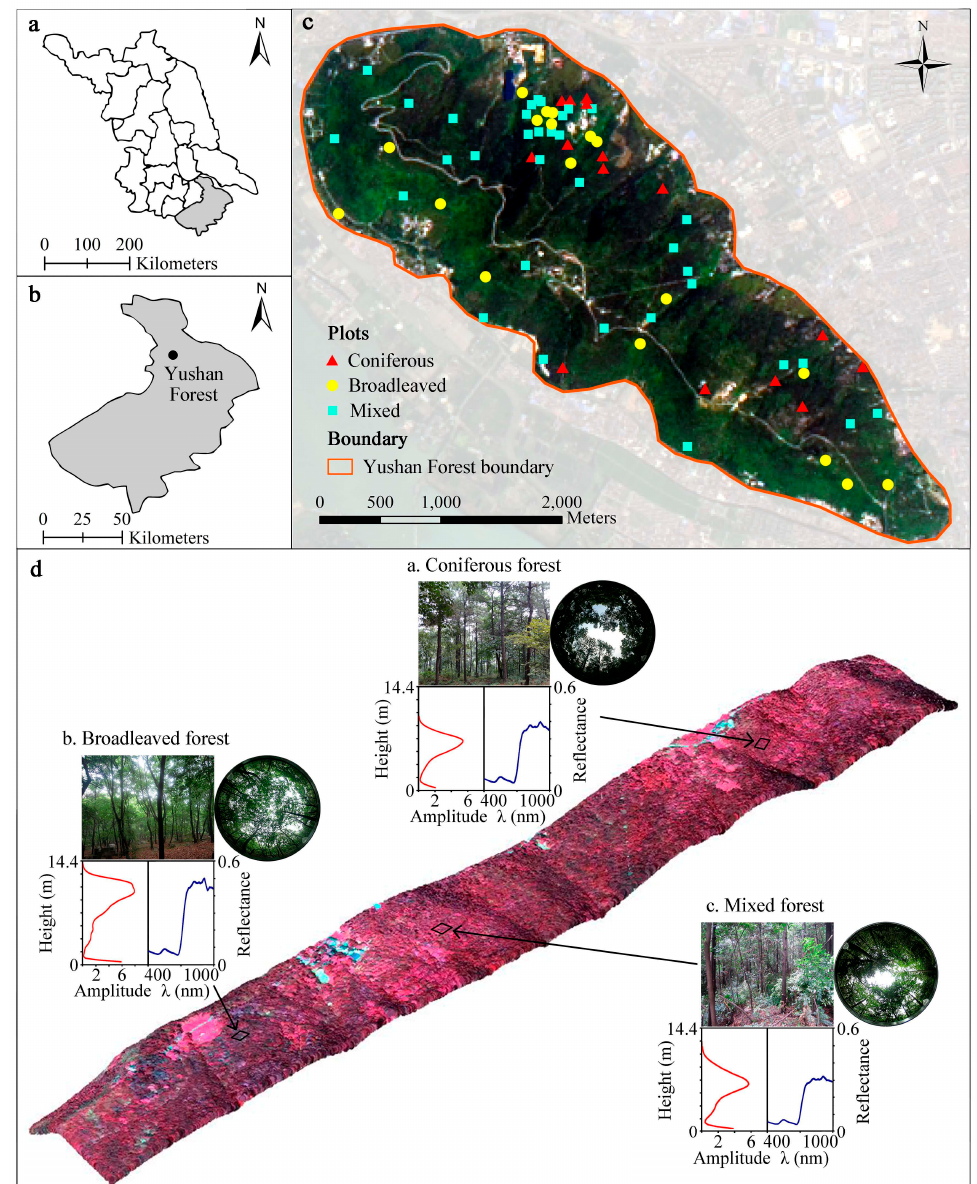
Figure 2. ( a , b ) Location of the Yushan Forest study site in Suzhou city, Jiangsu province; ( c ) the remote sensing image of Yushan Forest with a true color composition and the plot distributions of the three forest types; ( d ) three-dimensional display of a strip of point cloud data (the color of each point is extracted from the hyperspectral image). Picture, hemispherical, composite waveform and spectral reflectance of three typical forest plots are presented along the strip.